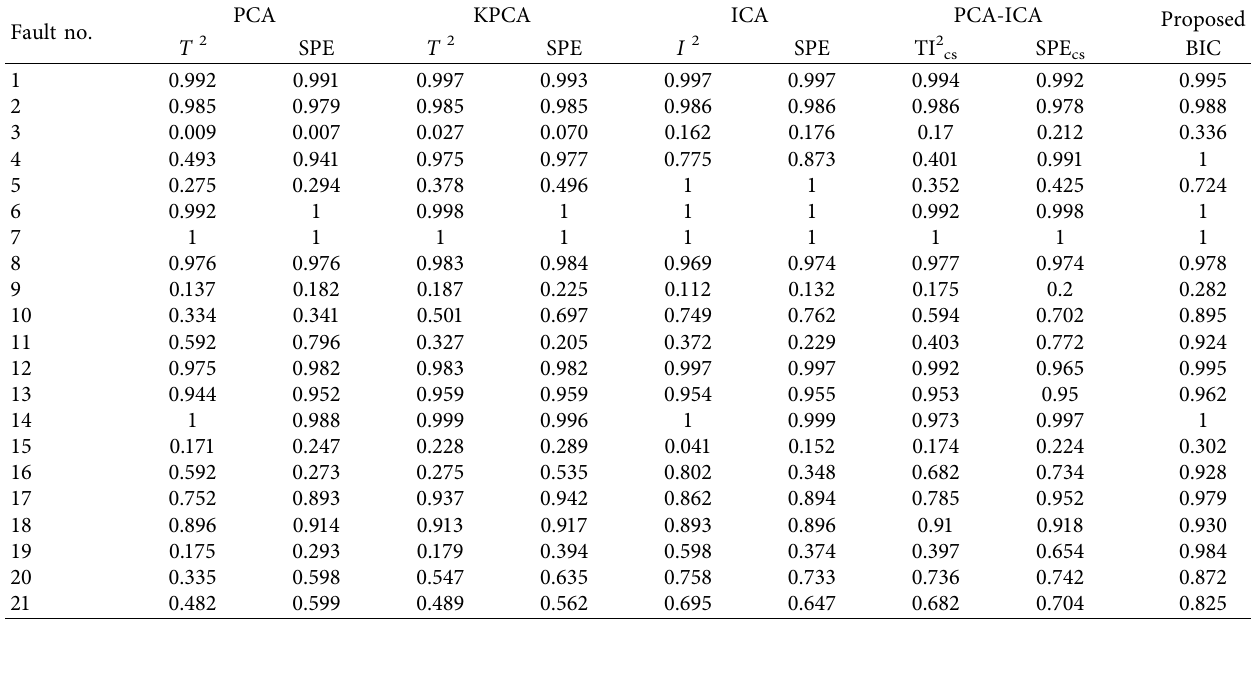
Table 4: Detection rates of 21 faults.